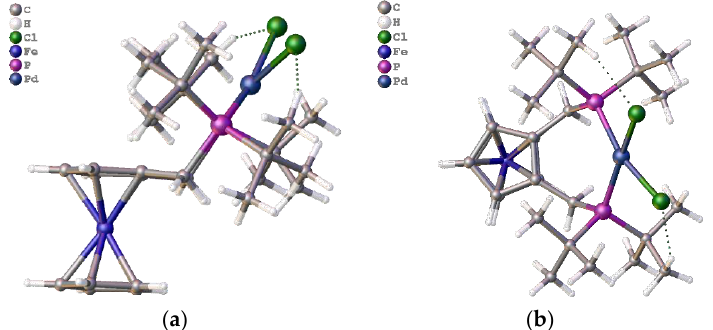
Figure 16. ( a ) Side view and ( b ) top view of palladium dichloride complex of butphos , 2a [Pd(L 2a )Cl 2 ].